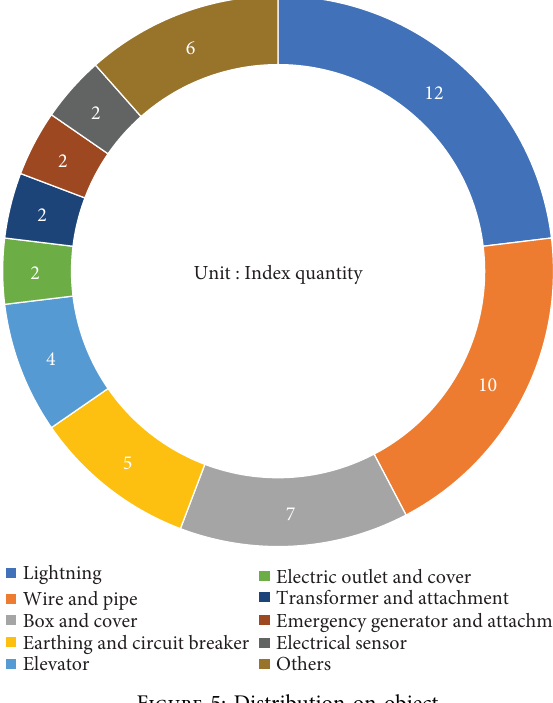
Figure 5: Distribution on